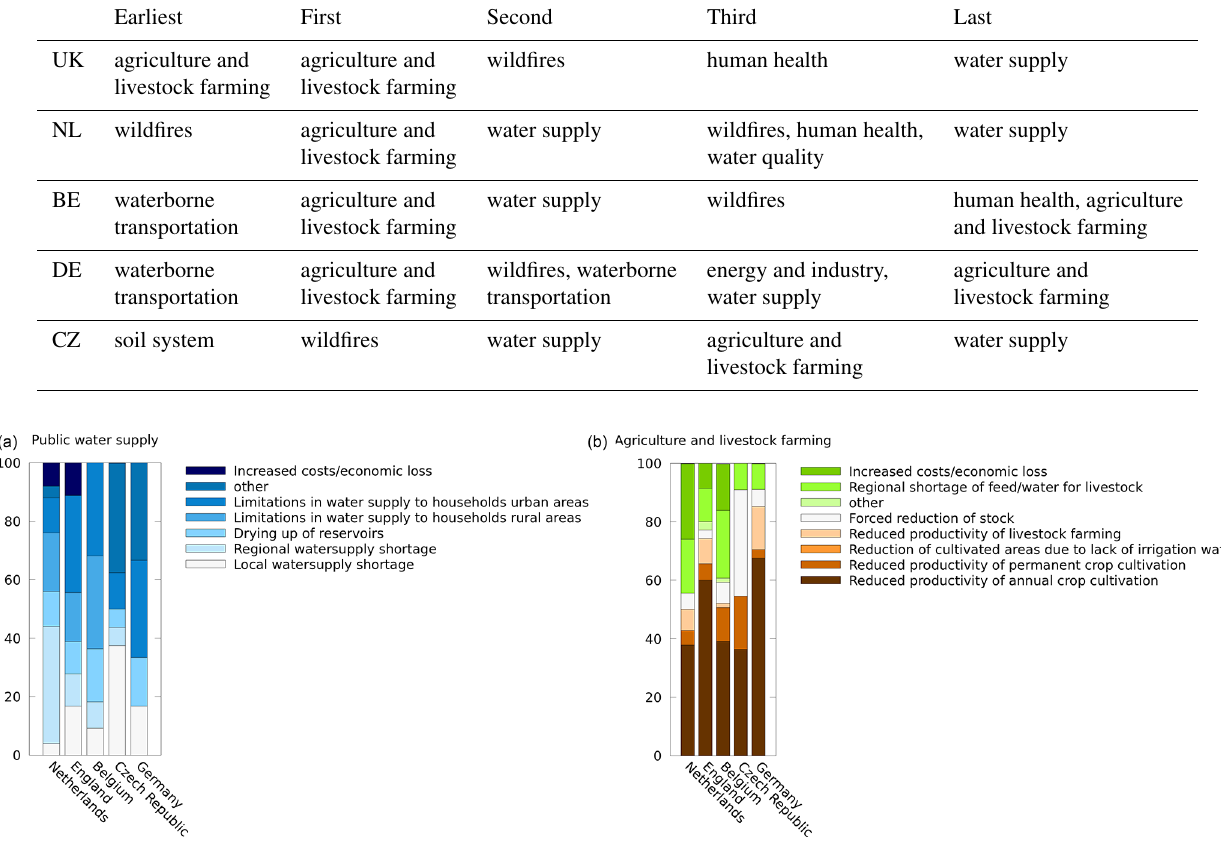
Figure 2. Reported impact types in public water supply (a) and agriculture and livestock farming (b) for the five